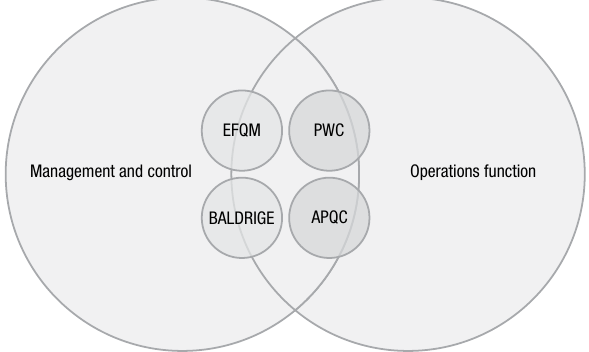
Fig. 3. Frameworks orientation. Management or operations Source: created by